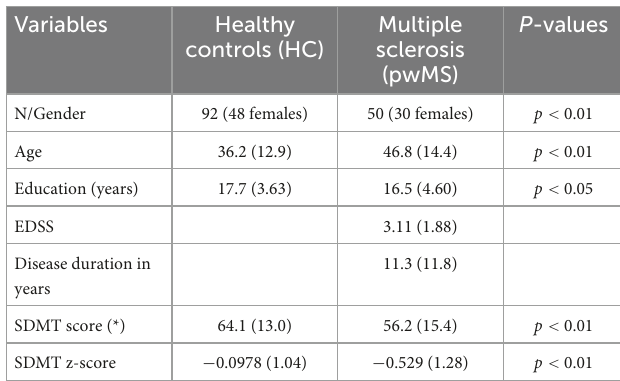
TABLE 1 Descriptive analysis of demographics and clinical variables in patients with multiple sclerosis (pwMS) and healthy controls